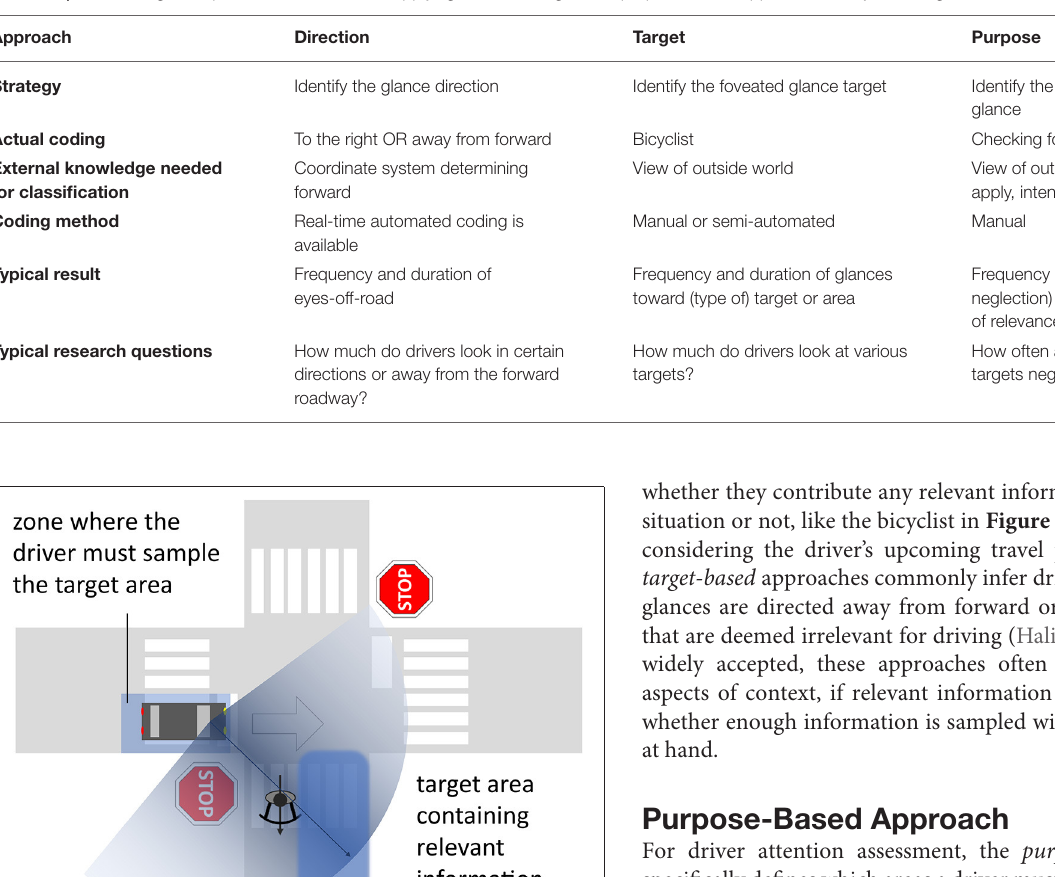
TABLE 1 | Methodological aspects to consider when applying direction, target, and purpose-based approaches to eye tracking data.